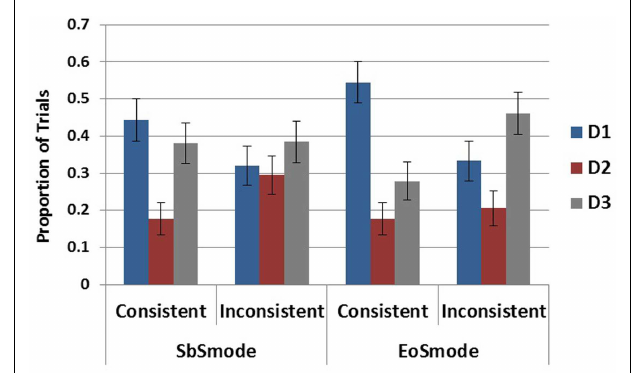
FIGURE 7 | Proportion of generation for each disease by response mode and ecology conditions. Error bars represent standard errors of the mean.